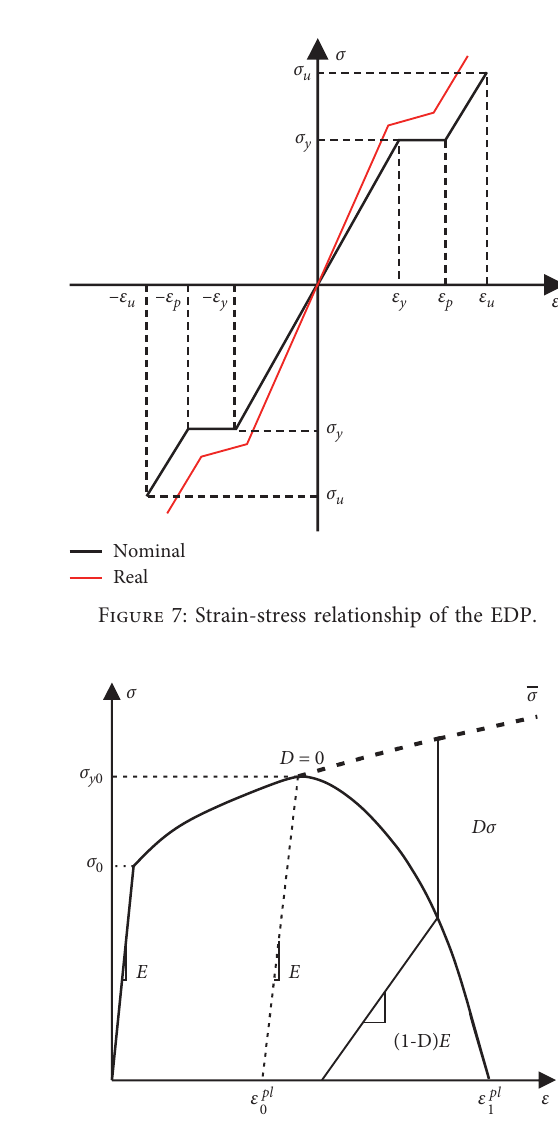
Figure 8: The strain-stress relationship of the damage degradation model.